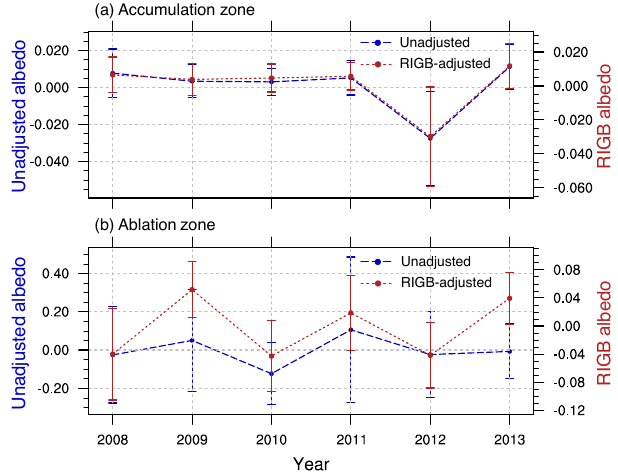
Figure 7. Annual average albedo using unadjusted data (on the left y axis) and RIGB-adjusted data (on the right y axis) in (a) accu- mulation zone; (b) ablation zone with standard deviation as error bars. The values are anomalies against the corresponding station